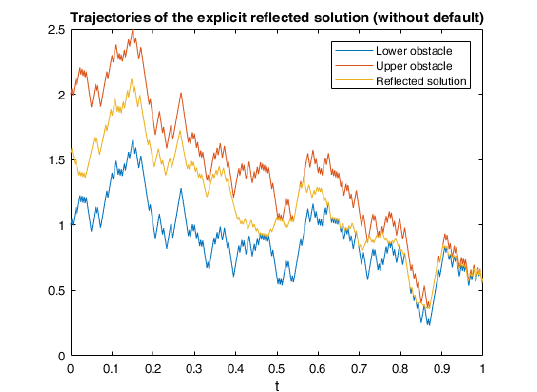
Figure 7. One path of ˜ y n in the explicit reflected scheme without default risk.